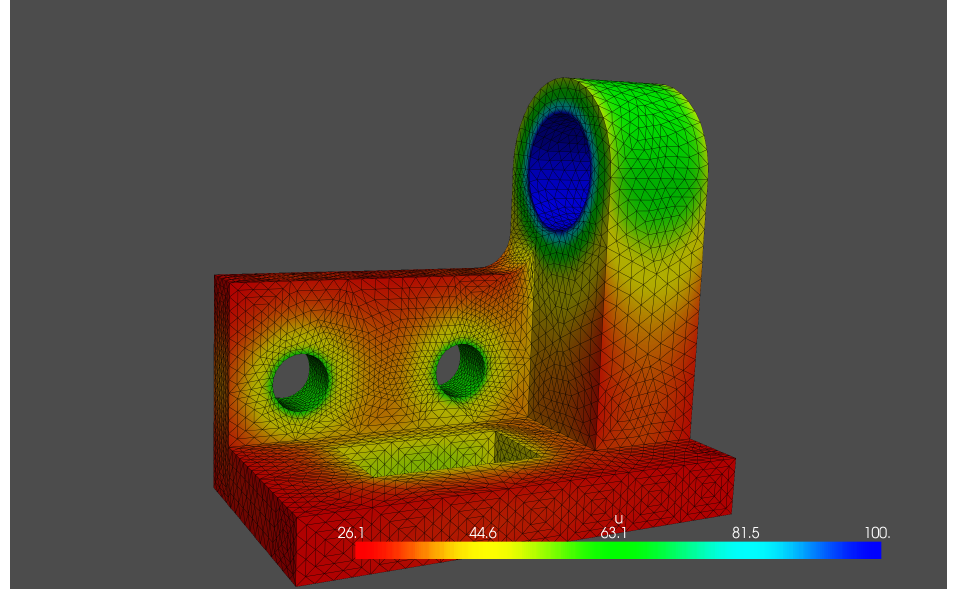
Figure 4. Temperature contour of a function space of order 1.